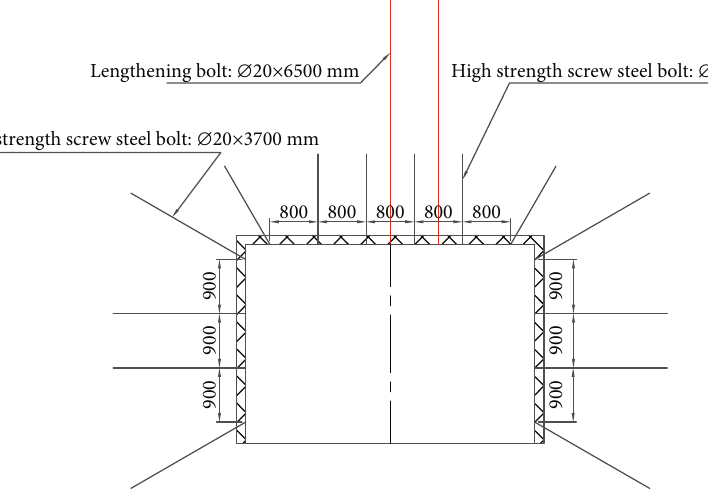
Figure 13: Section diagram of supporting design parameters for 11030 working face transportation roadway.